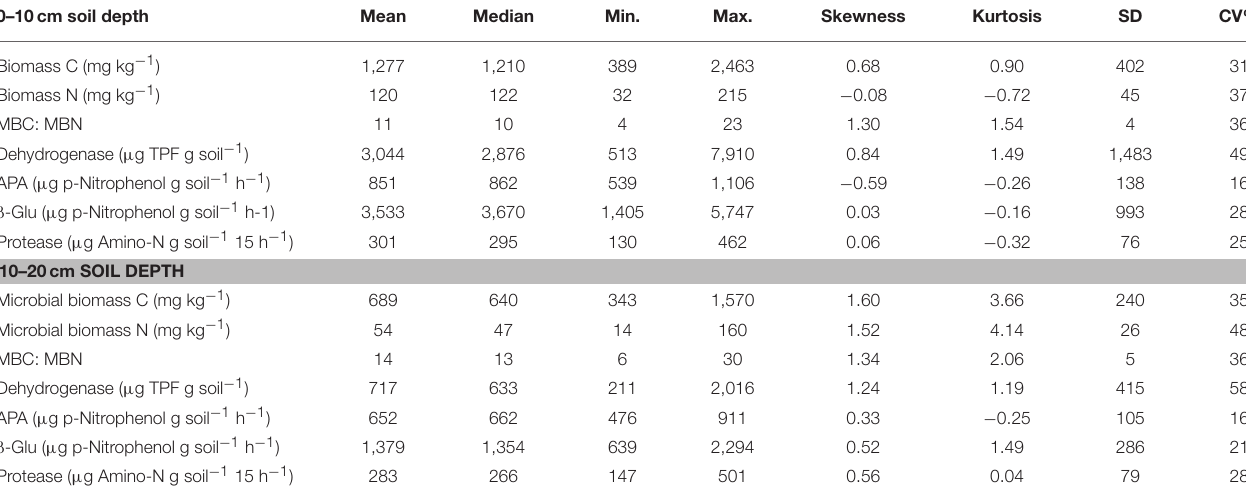
TABLE 4 | Soil microbial biomass and enzyme activities in surface and subsurface soil of a rewetted peatland. 0–10cm soil